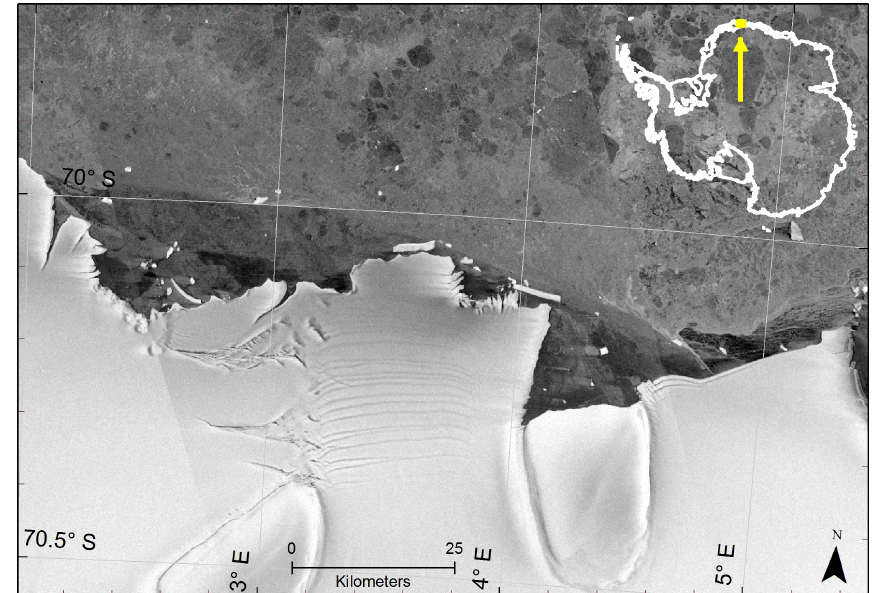
Figure 8. Icebergs calved from a parallel crevassed coastline. The SAR image shows the Fimbul Ice Shelf. In the upper right the location of this area (yellow rectangle) is indicated. The white lines in the inset image represent the coastline taken from RAMP AMM-1 (http://bprc.osu.edu/rsl/radarsat/data/) and the grounding line taken from Haran et al . [23]. Image courtesy: Byrd Polar Research Center &